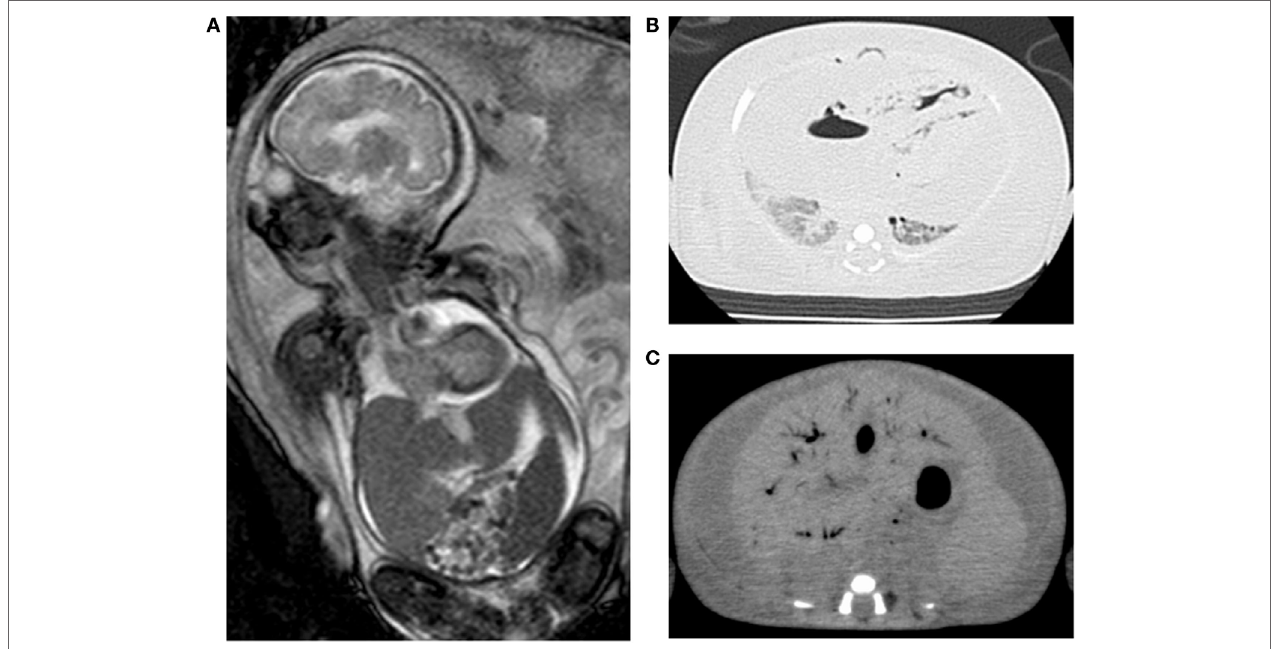
FIgURe 2 | Images of case 2. Fetal magnetic resonance imaging shows massive ascites, hepatomegaly, and compressed lungs (a) . Postmortem chest (B) and abdominal CT (C) show pulmonary hypoplasia and massive ascites with